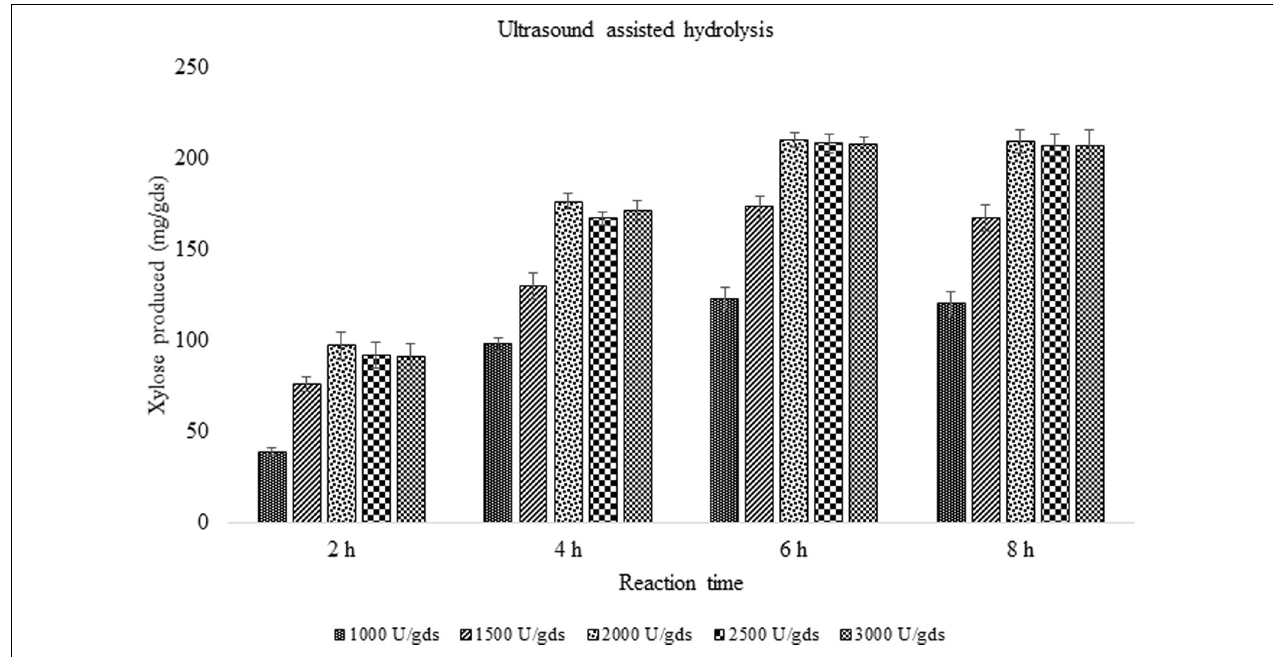
FIGURE 5 | Effect of ultrasound on enzyme saccharification of pretreated corn cob residue by crude enzyme extract obtained